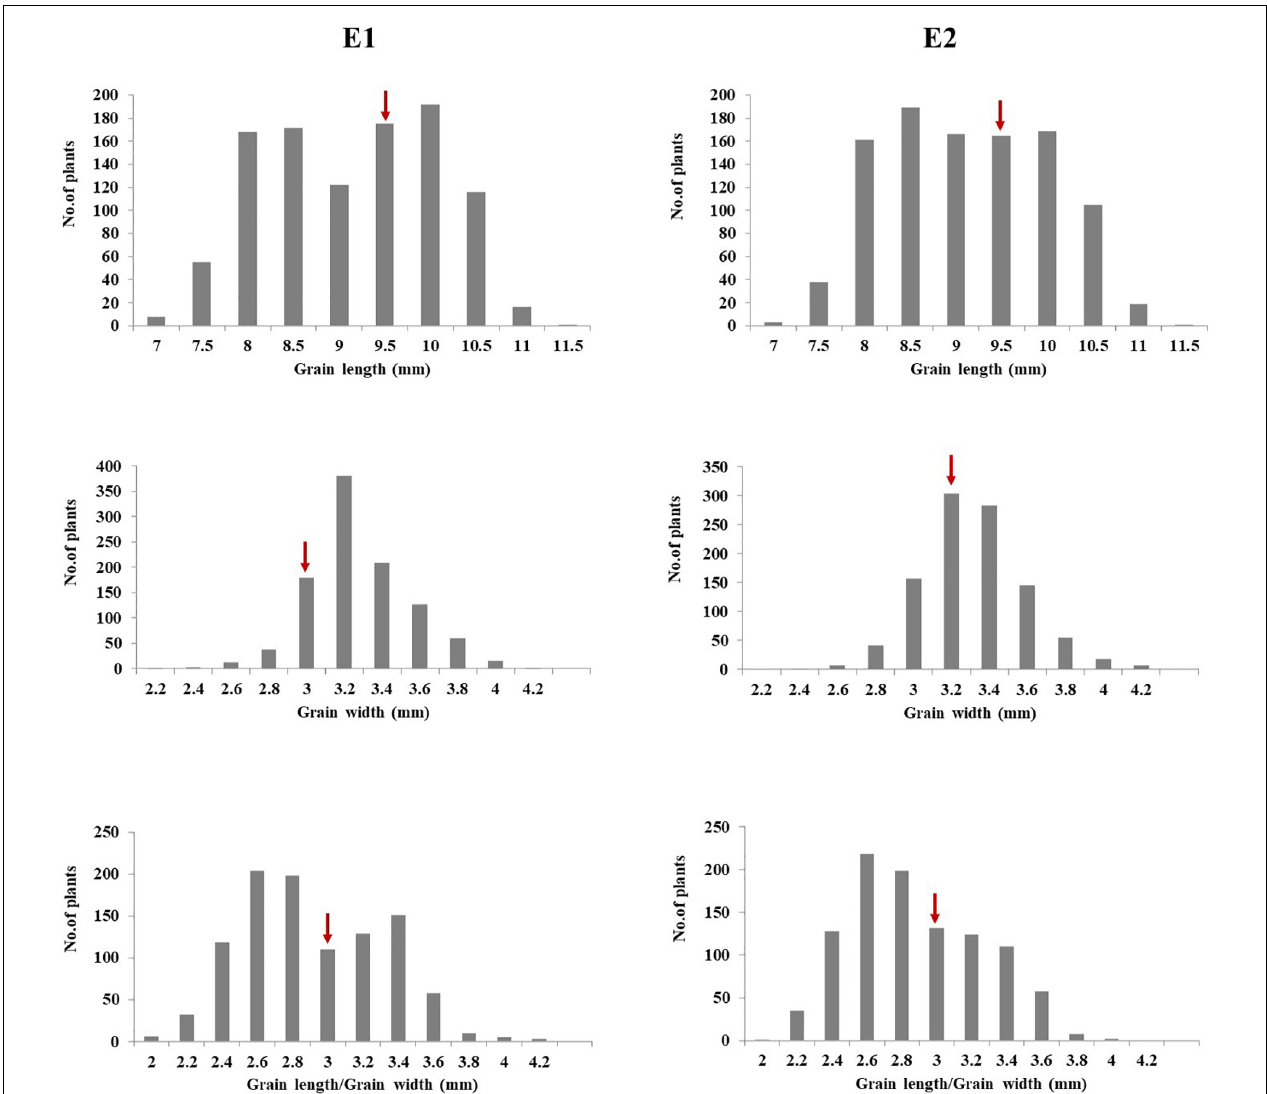
FIGURE 2 | Frequency distribution of grain size traits in introgression lines in the Dianjingyou 1 background. Arrows indicated the mean values for recurrent parent Dianjingyou 1.